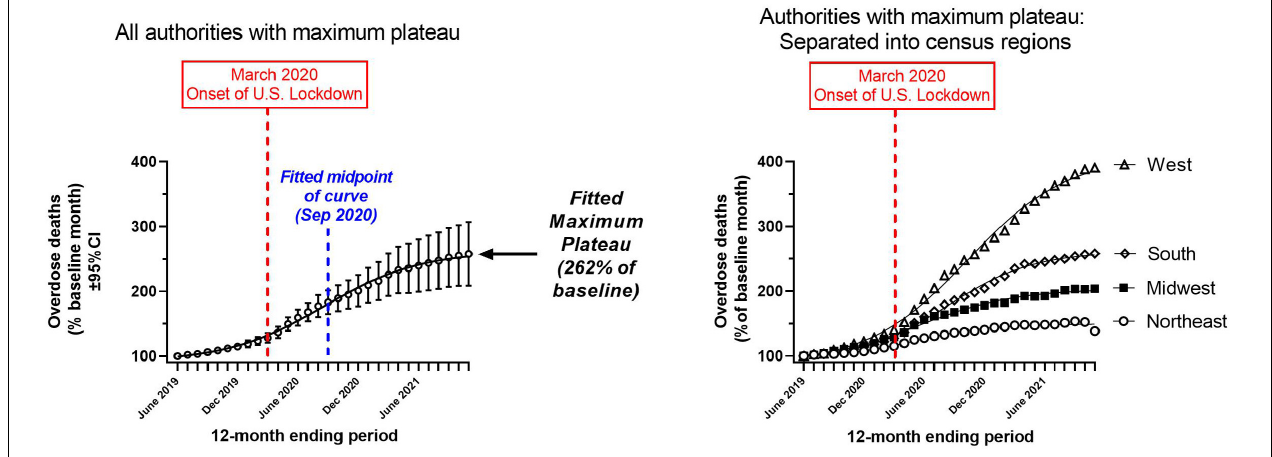
FIGURE 3 | Sigmoidal regressions of mortality, normalized as percent of the baseline month (June 2019) for the 29 authorities which had a maximum plateau in the last 4 months of the study period (August 2021–November 2021; Table 1 ). Left panel: Overall regression for these 29 authorities. Right panel: Separate regressions for four census regions; confidence intervals not shown. X -axes: month; Y -axes: mortality rate (percent of baseline month). Table 2 shows the parameters of the sigmoidal fits.